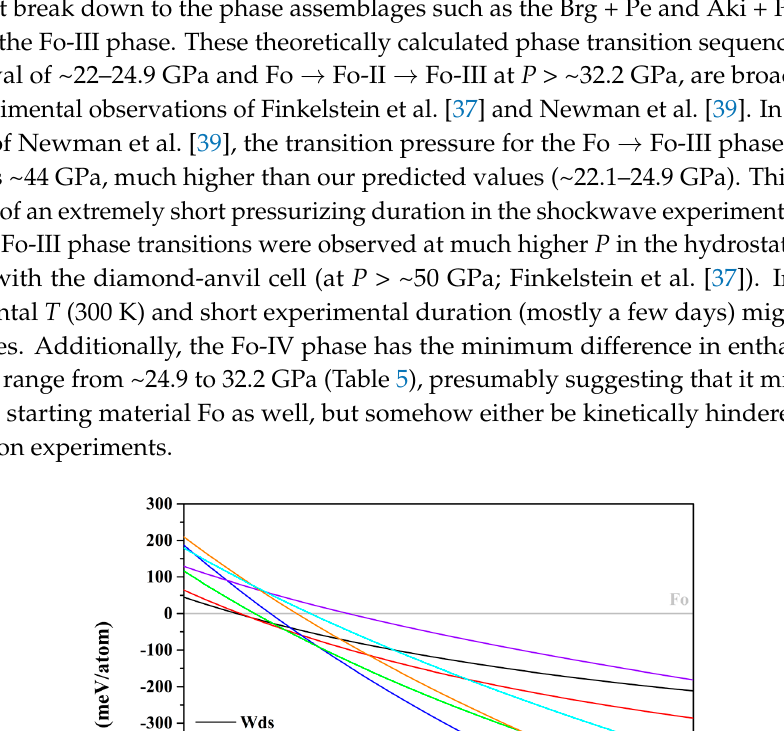
Table 5. P range of the thermodynamically stable phase assemblage for the Mg 2 SiO 4 composition and P for the polymorphic phase transition from Fo, Wds and Rwd to Fo-II, Fo-III and Fo-IV, based on our calculated enthalpies at 0 K (0–100 GPa; Figure 7).